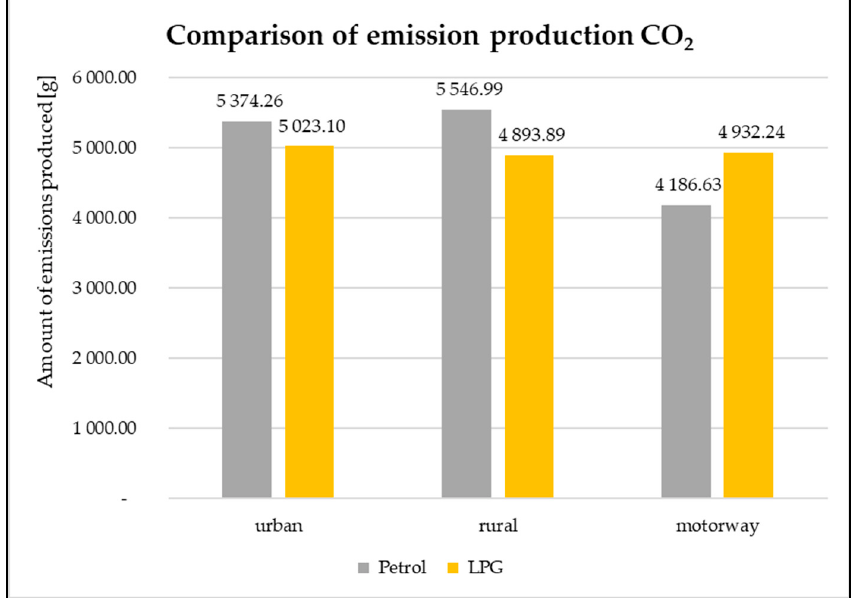
Figure 13. Comparison of CO 2 production [measurement results processed by the author].